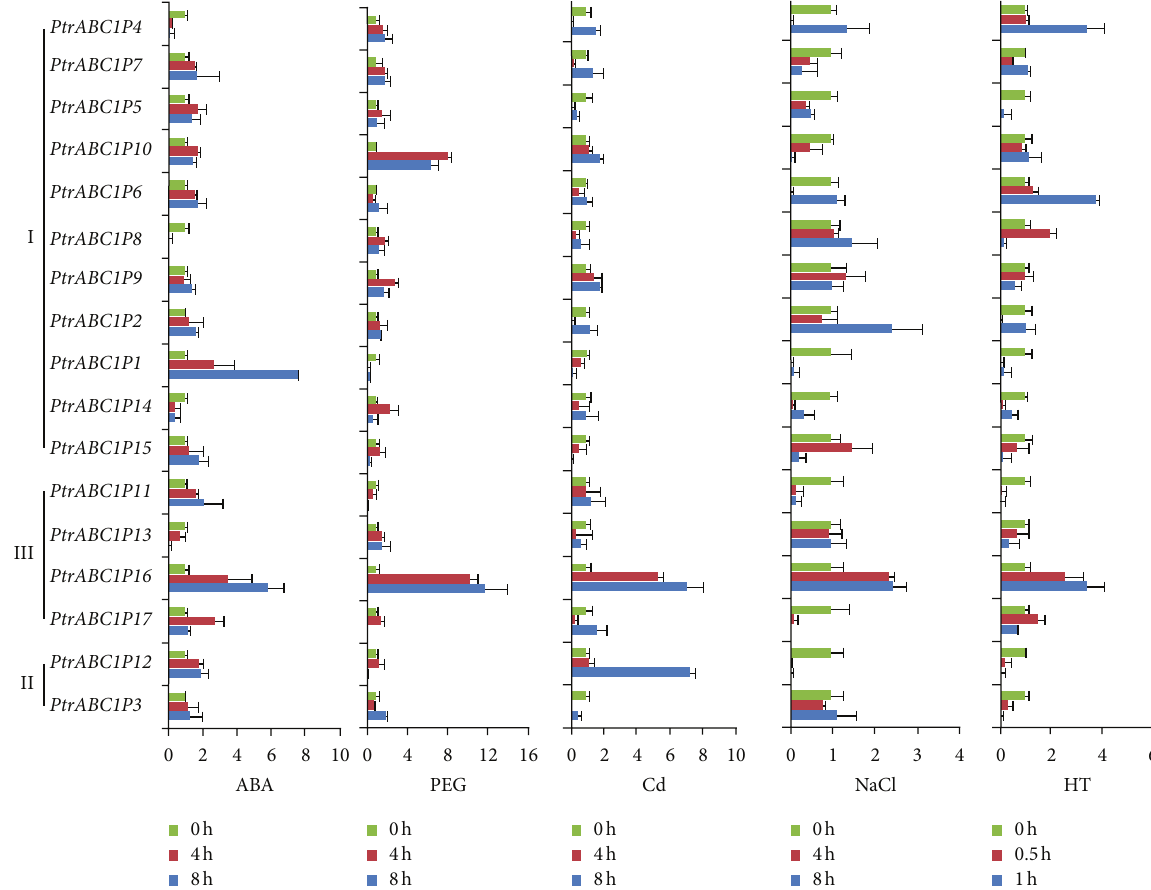
Figure 6: Relative expression of the 17 P. trichocarpa ABC1 genes. The five treatments investigated were ABA, PEG, Cd, NaCl, and HT (high temperature). I, II, and III represent the three groups shown in the phylogenetic tree in Figure 2. 0h represents no treatment. 0.5, 1, 4, and 8h represent the corresponding times under different